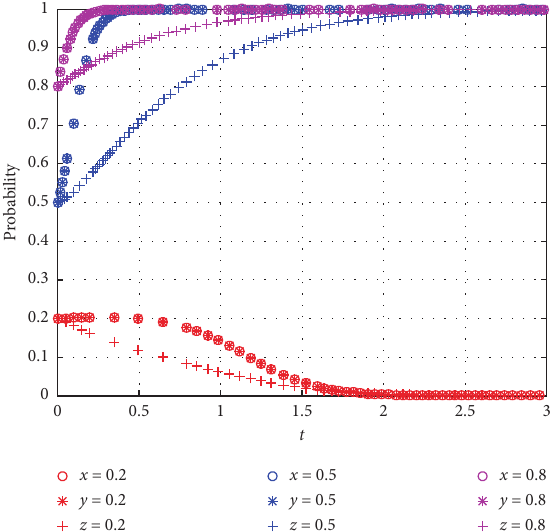
Figure 5: Evolution paths of scenario 4 under different initial